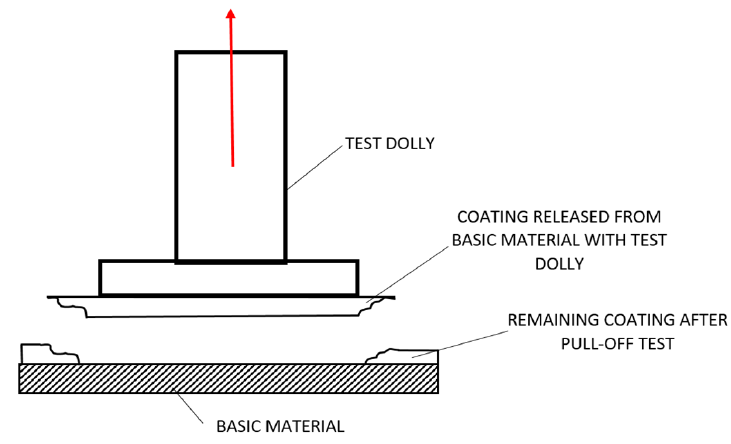
Figure 1. Scheme of pull-off test.